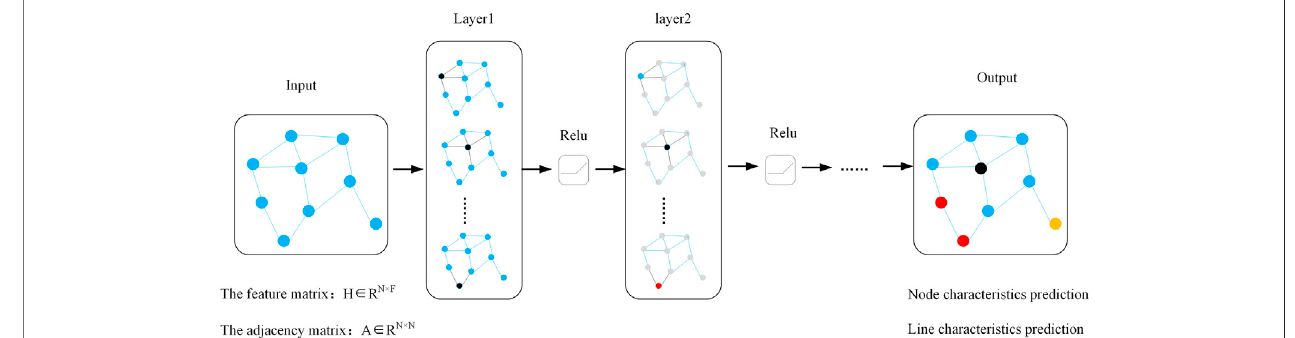
FIGURE 4 | Flowchart of graph neural network.